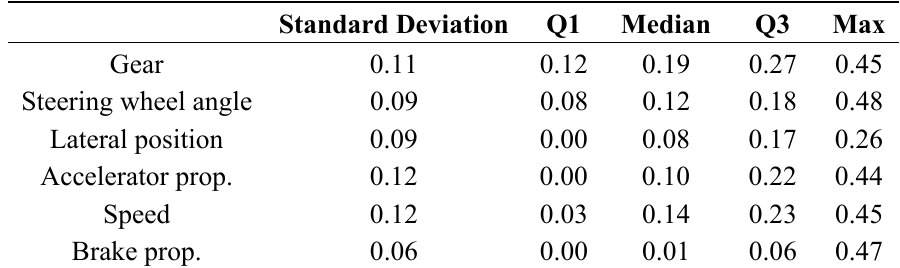
Table 3. Relevant characteristics for the Fusion of Experts ( n = 10,000).